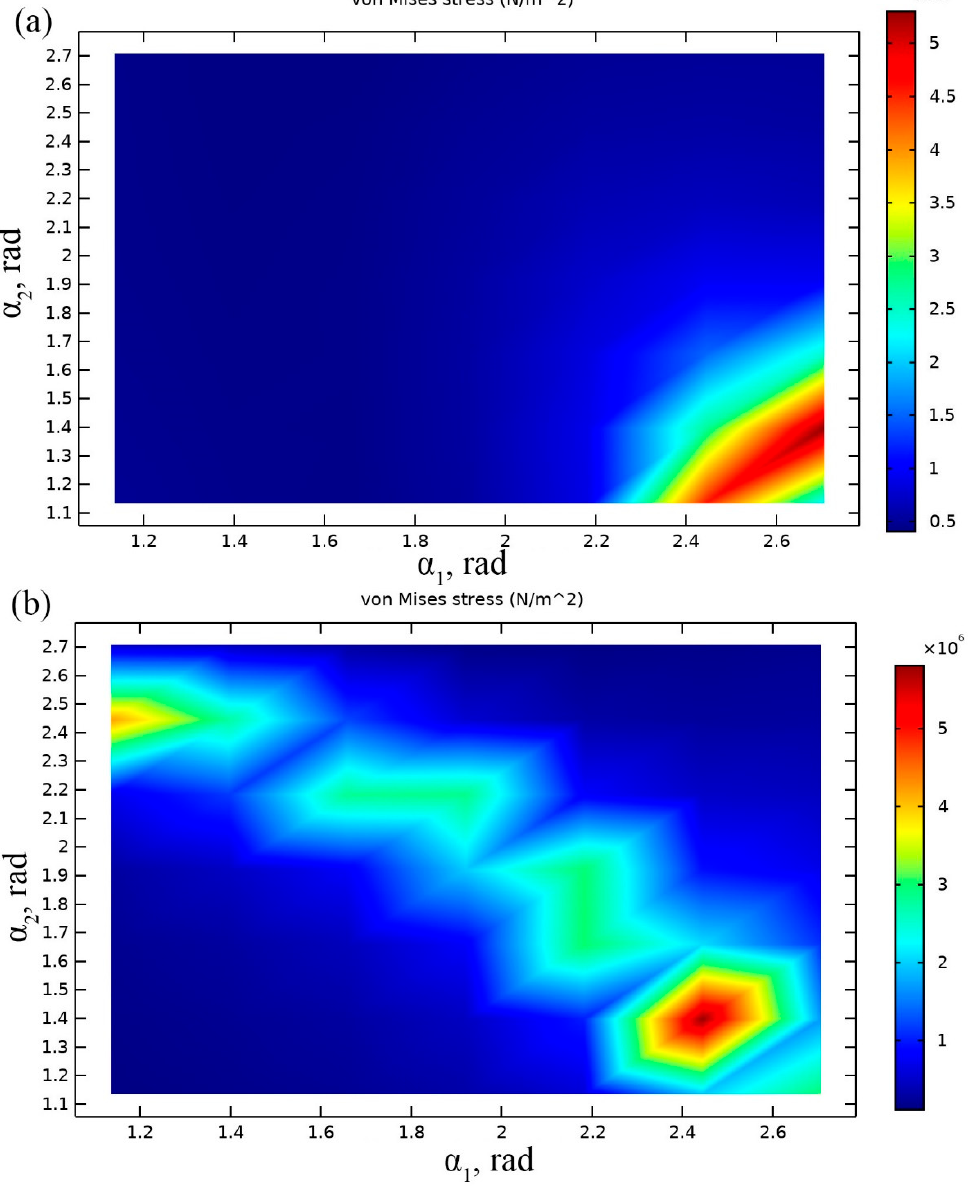
Figure 5. Plot of von Mises stresses at the resonance frequency when different α 1 and α 2 are used: acceleration aligned to z direction, resonant frequency 14 Hz ( a ); acceleration aligned to y direction, resonant frequency 27 Hz ( b ).